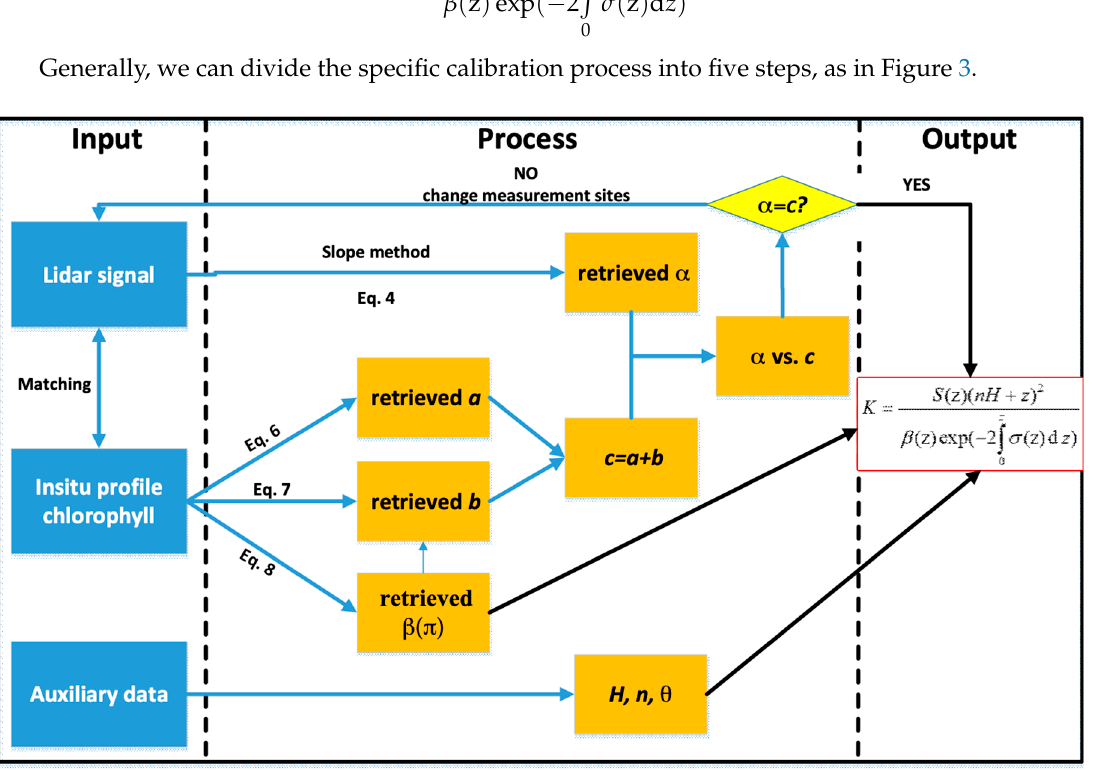
Figure 3. Flow chart showing the calibration process.